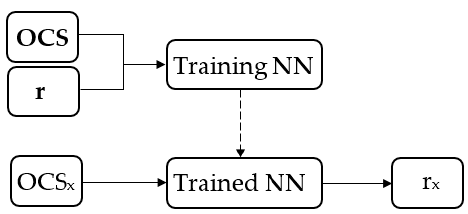
Figure 5. Training neural network (NN) and finding the ratio r x diagram.